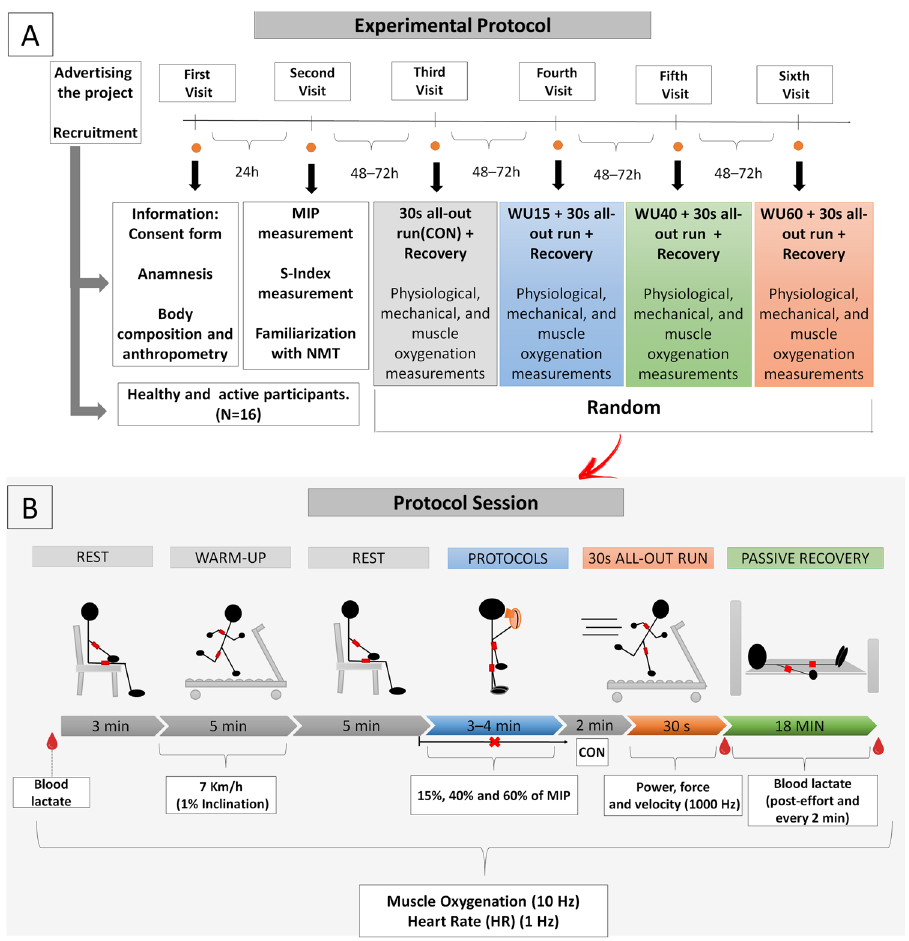
Figure 1. ( A ) Experimental protocol illustrating the procedures performed on each day during the whole study period. ( B ) Timeline of the protocol sessions. Physiological responses were monitored throughout the exercise and the 18 min of passive recovery. Near-infrared spectroscopy devices (NIRS, represented by the red rectangles) provided the biceps brachii and vastus lateralis oxygenation data. S-Index—global strength index; CON—Control session; WU15, WU40 and WU60—Warm-up with 15%, 40% and 60% of maximal inspiratory pressure (MIP),